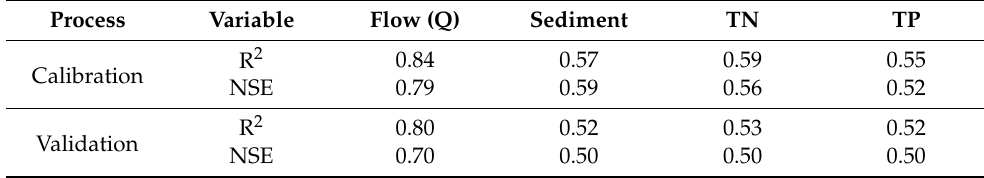
Table 5. R 2 and NSE of the four variables used in calibration and validation.